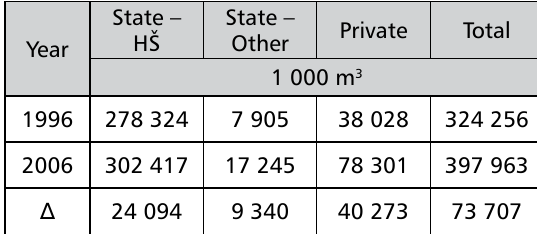
Carbon stock of forests (source [2, 6]) Year